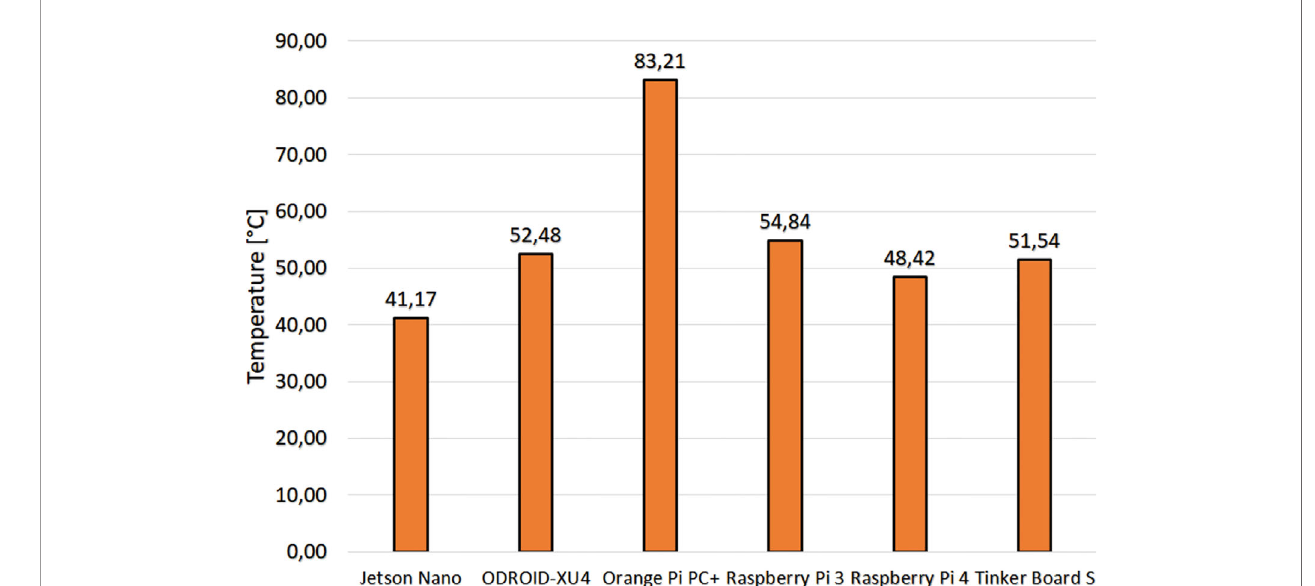
FIGURE 2 | Temperature of the processor of each embedded system.